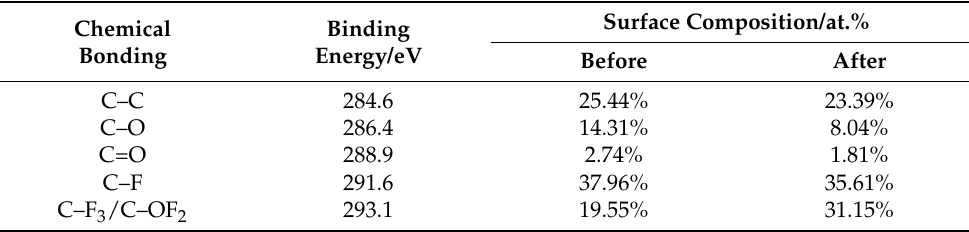
Figure 6. Potentiostatic polarization curves of bare Ti (black), carbon coating, C-PTFE/GS coating and C-PTFE/GS-CNT coating under cathodic (0.6 V vs. SCE, 70 ◦ C, 0.5 M H 2 SO 4 + 2 ppm HF, air bubbling) conditions. ( a ) potentiostatic polarization curves; ( b ) enlarge potentiostatic polarization curves. Table 3. Fitting parameters and relative quantity analysis of compounds for C 1s spectra of C-PTFE/GS-CNT films before and after corrosion by